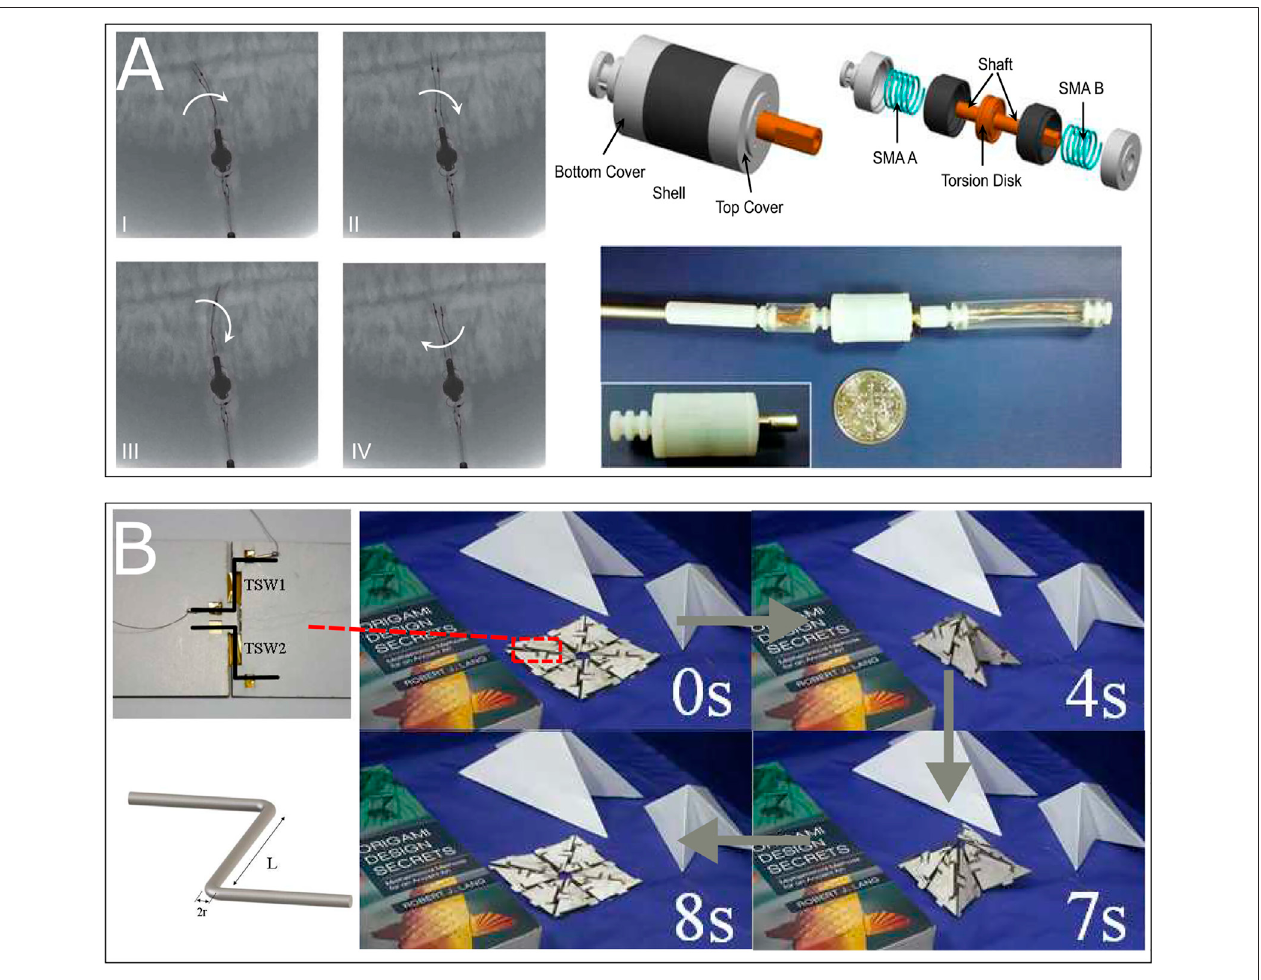
FIGURE 9 | Examples of BRM actuator using SMA torsional element: (A) A meso-scale BRM modular embedded 2 antagonist torsional springs for surgical application(Shengetal.,2017); (B) Ameso-scaleself-deployablepaper-basedopenorigamistructurethatcapableofswitchingbetween2D-3Dstate(Kohetal.,2014).